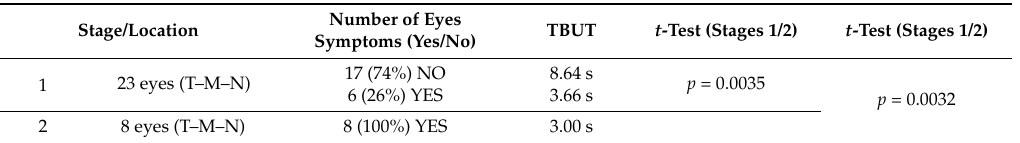
Table 6. Comparative data of TBUT values in eyes with or without symptoms with the same stage in each of the 3